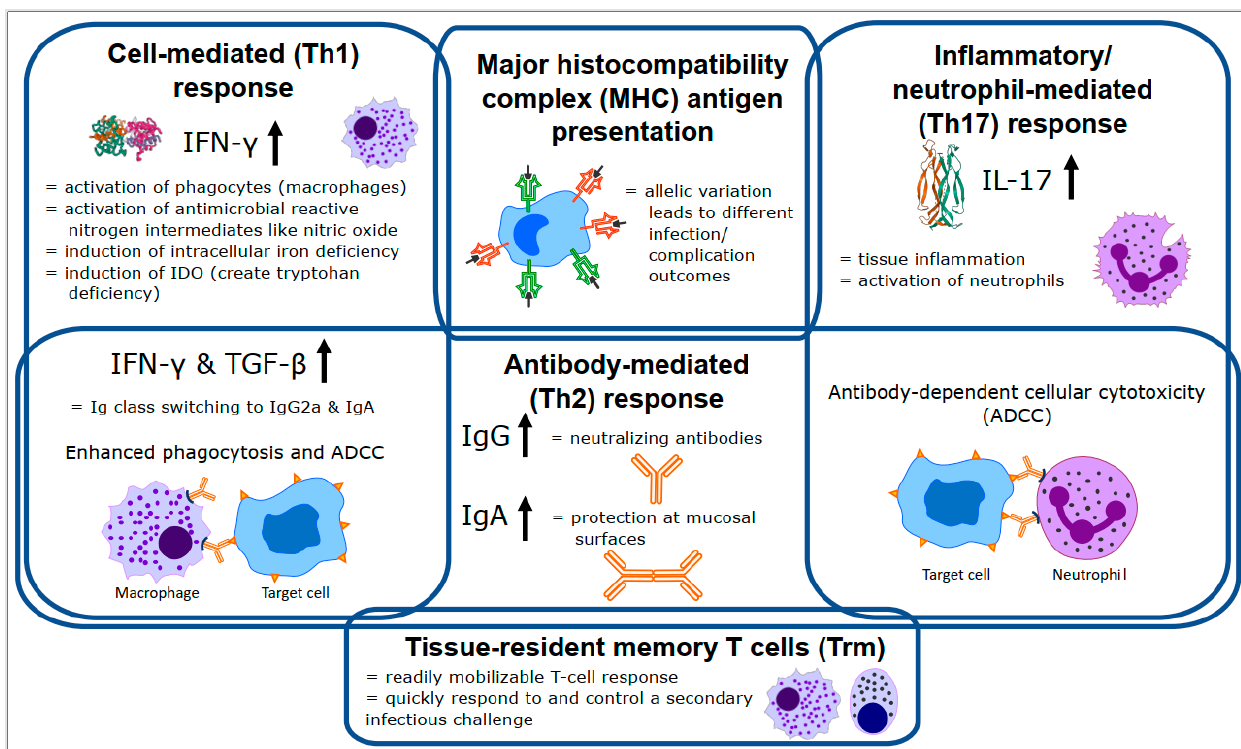
Figure 2. Overview of the major immune responses and components important for controlling chlamydial infection (based on the mouse immune response). Details of each process are described in the text. Th = T helper cell, MHC = major histocompatibility complex, IFN- γ = interferon gamma, IL-17 = interleukin 17, TGF- β = transforming growth factor beta, ADCC = antibody-dependent cellular cytotoxicity, Ig = immunoglobulin, IDO = indoleamine-2,3-dioxygenase.